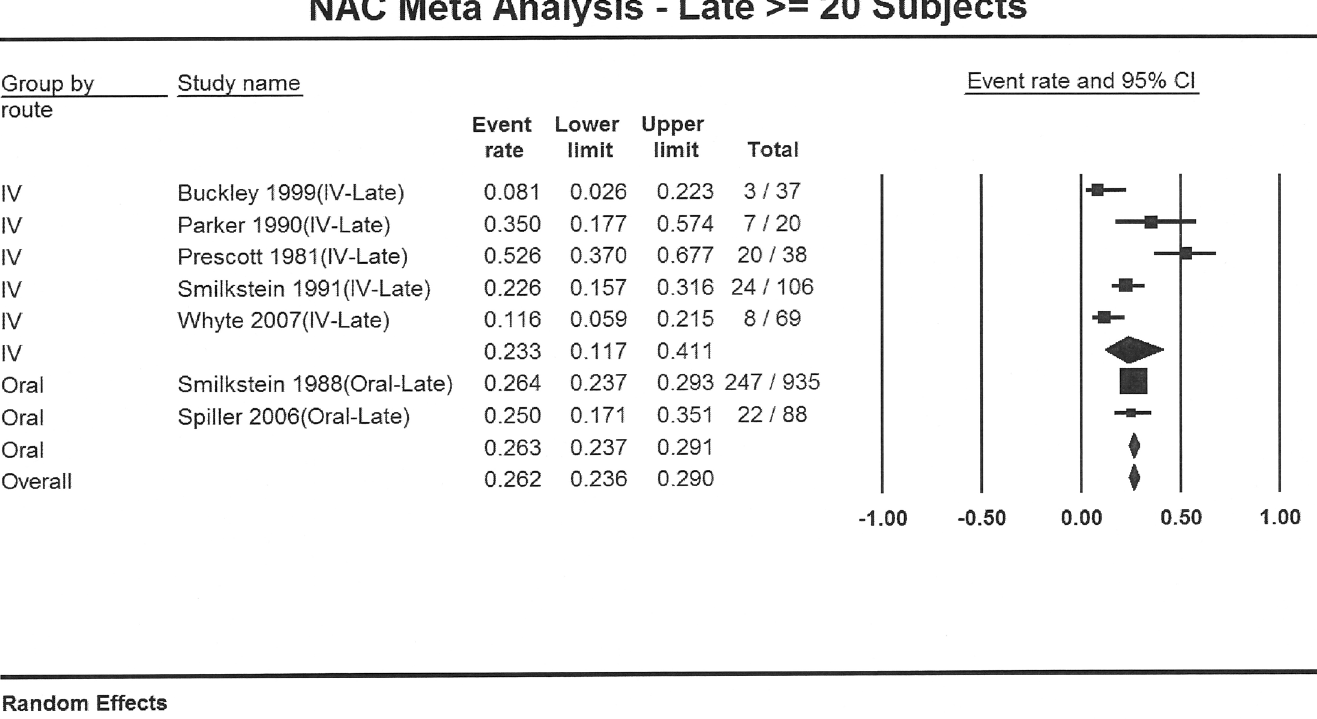
Figure 4. Forest plot showing proportion of patients with acetaminophen poisoning who developed hepatotoxicity for intravenous and oral acetylcysteine treatment when acetylcysteine was administered late (more than 10 hours or as defined by